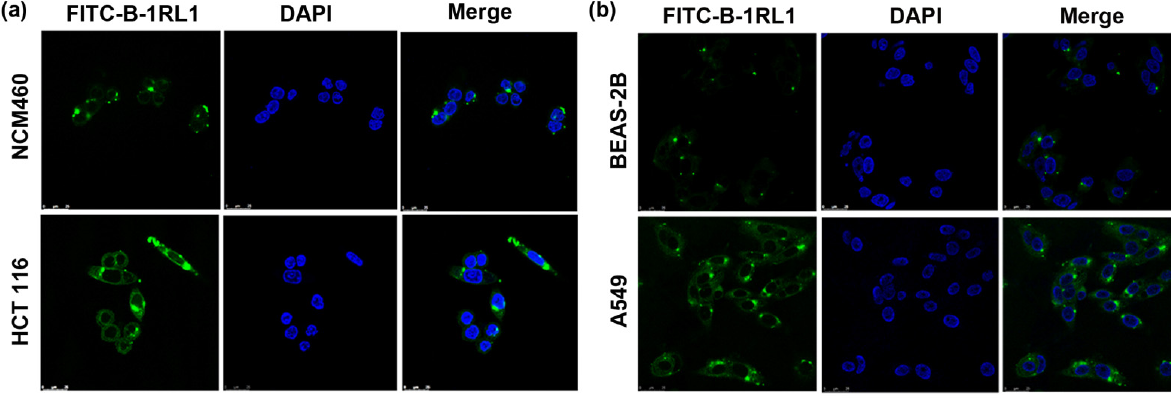
Figure 5 . Brevinin-1RL1 localization and binding affinity in tumor cells. Location of Brevinin-1RL1 in NCM460 and HCT116 cells ( a ), BEAS-2B and A549 cells ( b ). Cells were seeded on glass-bottom 6-well plates and treated with FITC-labeled Brevinin-1RL1 for 12 h. Then, the FITC-B-1RL1 was traced and recorded using laser scanning confocal microscopy. ( c ) The binding affinity of Brevinin-1RL1 in NCM460 and HCT116 cells ( c ), BEAS-2B and A549 cells ( e ). 1 × 10 6 /mL HCT116, NCM460, A549 and BEAS-2B cells were collected and incubated with FITC-B-1RL1 or an equal dose of FITC Isotype as controlin the dark for 1 h. Fluorescence alteration was detected by flow cytometry. ( d ) The MFI (Median Fluorescence Intensity) value was statistics from ( c ). ( f ) The MFI value was statistics from ( e ). *p < 0.05, **p < 0.01 and ***p < 0.001 in comparison to negative controls (Isotype), and indicated the significant difference between the two groups. Data expressed as the mean ± SD (n = 3). 3. Discussion